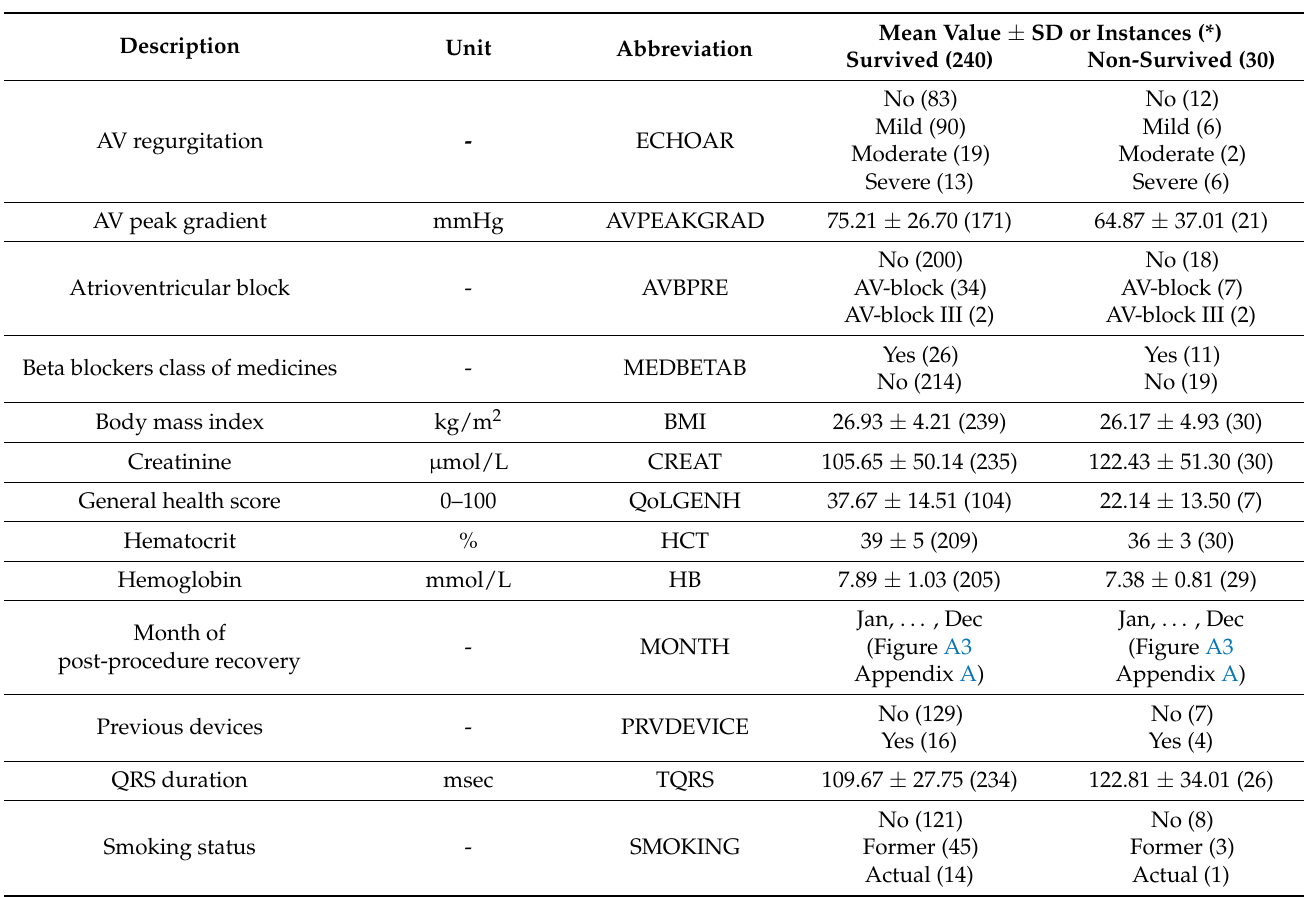
Table 3. Details of the most important features for the prediction. Numerical data distribution is shown in Figure A1 (Appendix A).